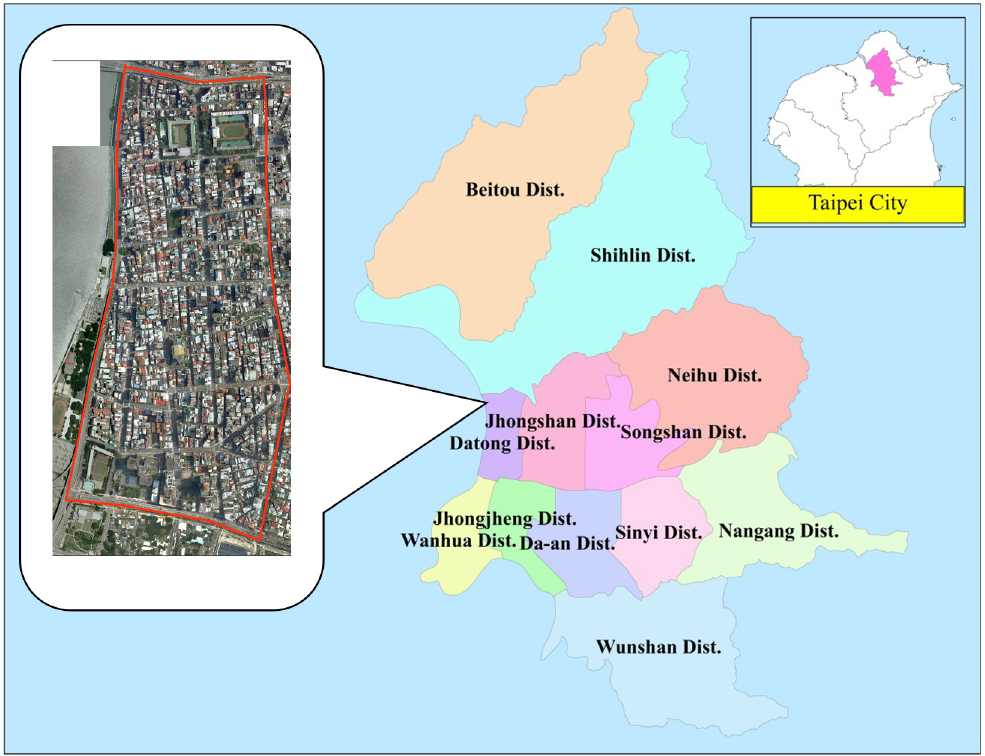
Figure 3. Map of Sample Site at Datong District, Taipei